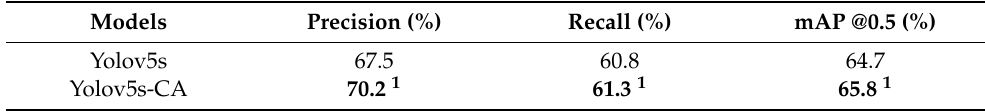
Table 1. Performance comparisons of models trained only on real field